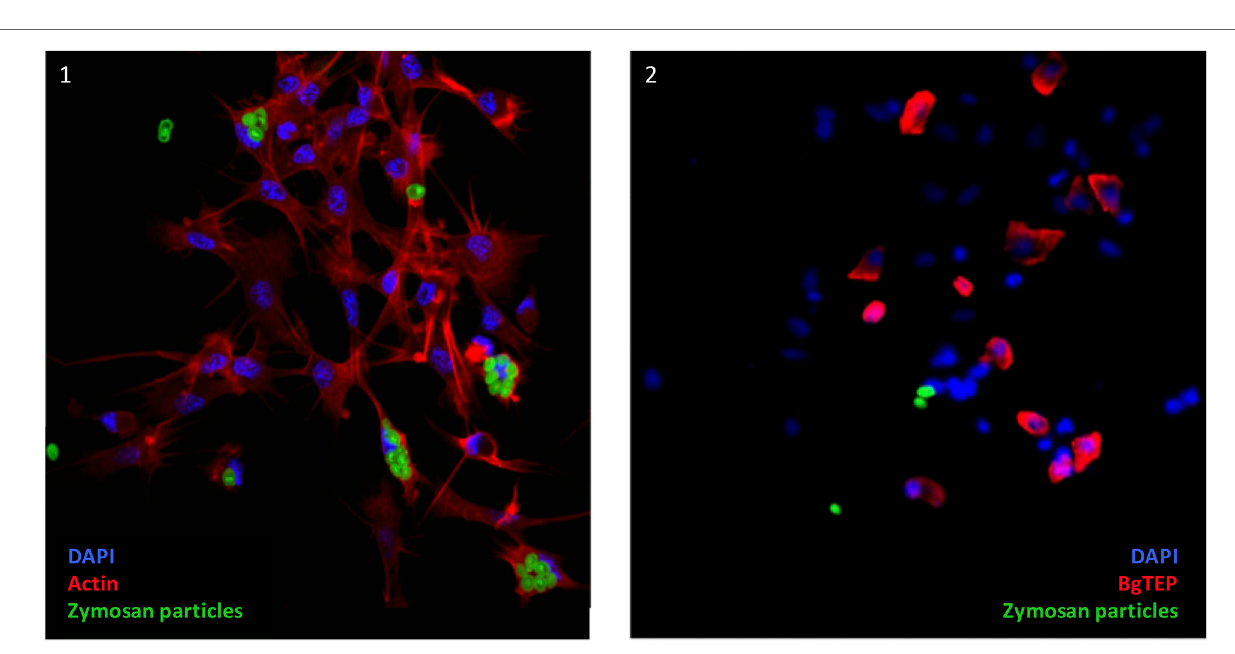
FigUre 8 | BgTEP-positive cells do not phagocyte. Phagocytosis of green fluorescent zymosan particles in hemocytes observed by confocal microscopy. On picture 1, Alexa-594 phalloidin was used to label actin of all hemocytes (red). Phagocytosis assay was monitored using green fluorescent yeasts. On picture 2, BgTEP- positive cells were detected by immunolocalization using the antibody anti-BgTEP-PEP and an Alexa Fluor 594 dye conjugated to the secondary antibody (red).